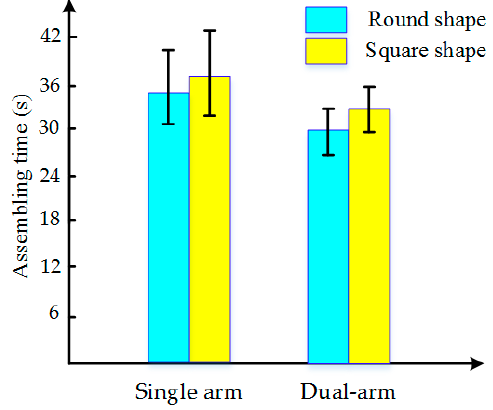
Figure 20. Comparison of forces and torques deviation (( a , b ): deviation of forces and torques of round pieces, respectively; ( c , d ): deviation of forces and torques of square pieces, respectively).